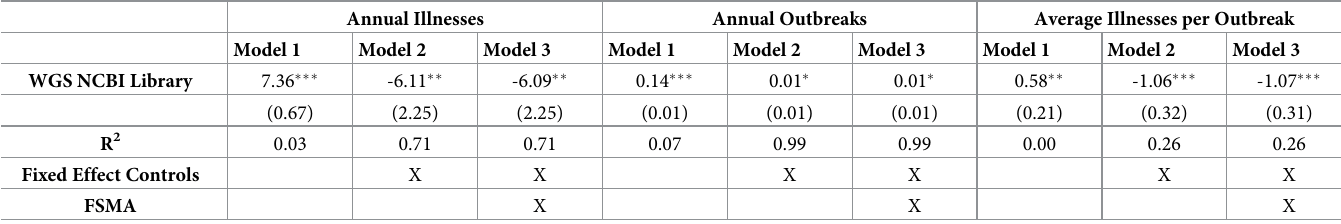
Table 2. Estimated effect of WGS library on illnesses and